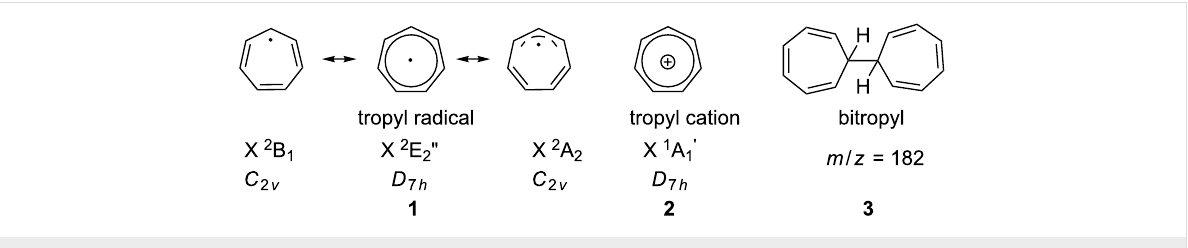
Figure 1: Structure of the tropyl radical 1 , its cation 2 and the precursor bitropyl 3 .